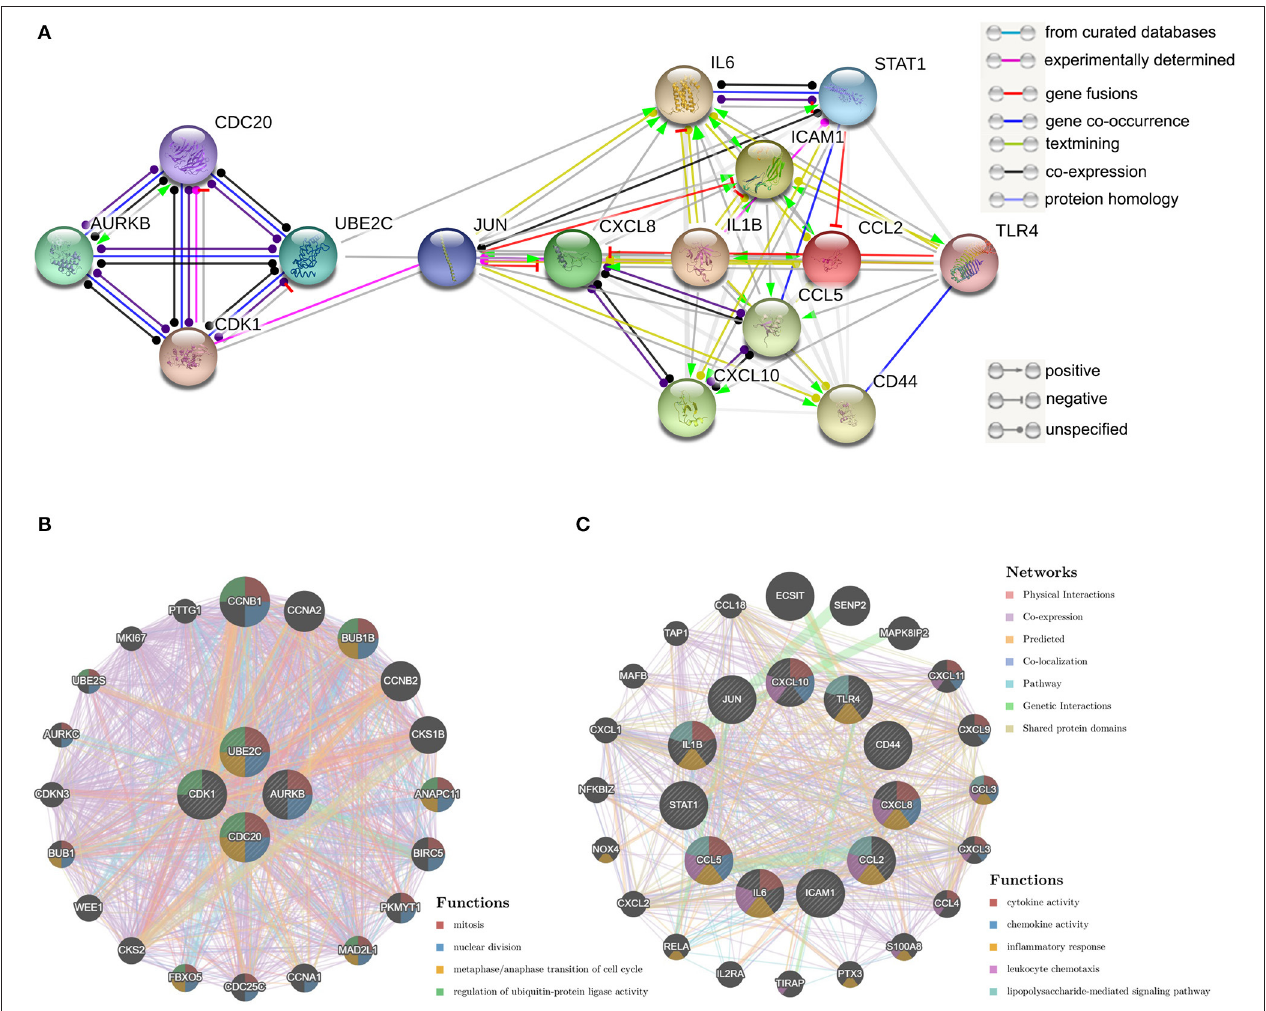
FIGURE 5 | Protein–protein interaction (PPI) network of hub genes. (A) The PPI network of the top 15 hub genes created by STRING; (B) PP1 networks and function analyses of the four downregulated hub genes; (C) PPI networks and function analyses of the 11 upregulated hub genes. Inner circles represent the input genes and outer circles correspond to GeneMANIA proposed hub genes, the size of the circles indicates the correlation with the input genes.